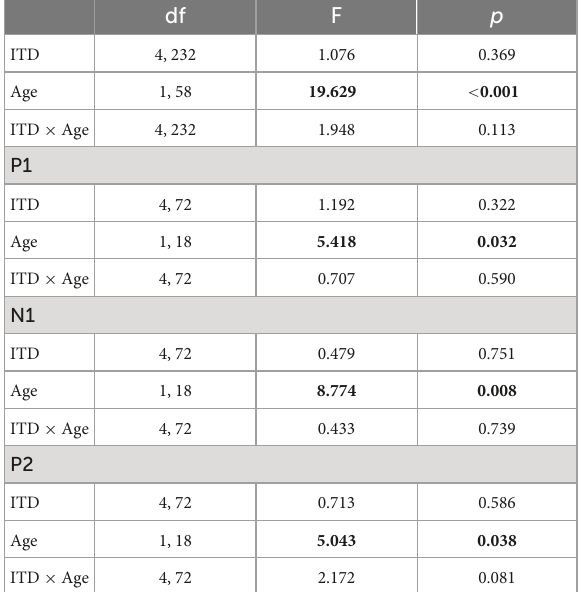
TABLE 2 Repeated-measures analysis of variance (ANOVA) results for binaural interaction component (BIC) sensor-level